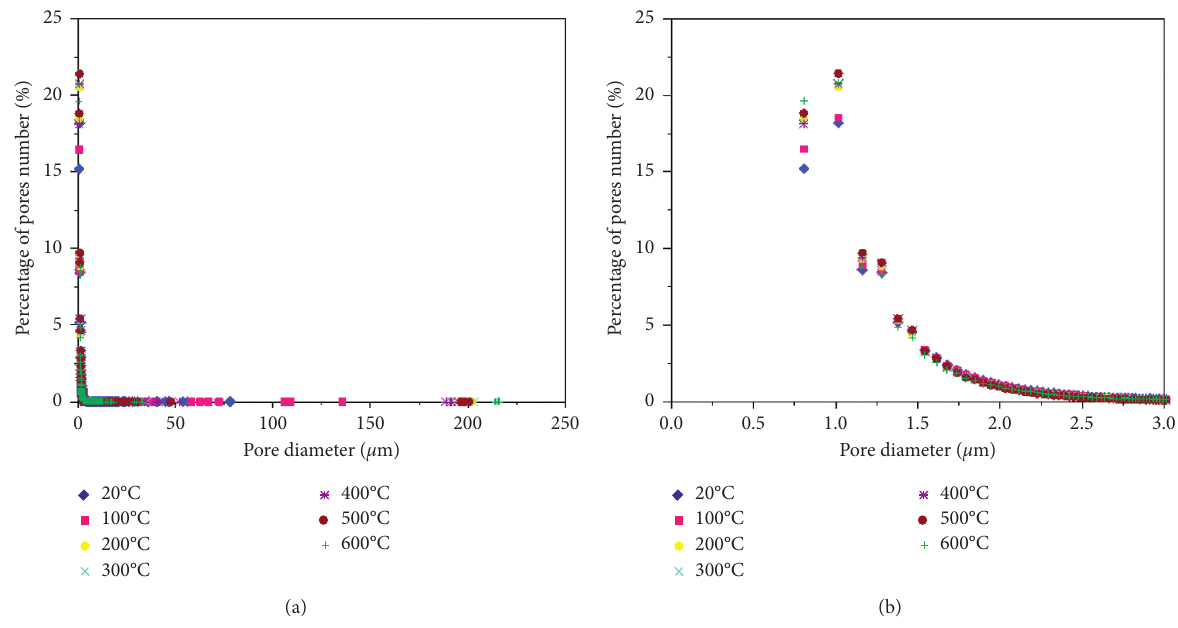
Figure 7: Pore distribution of lignite at different temperatures. (a) All measurable μ m-sized pores; (b) 0.65–3 μ m pores. 001.0 0.0 E +